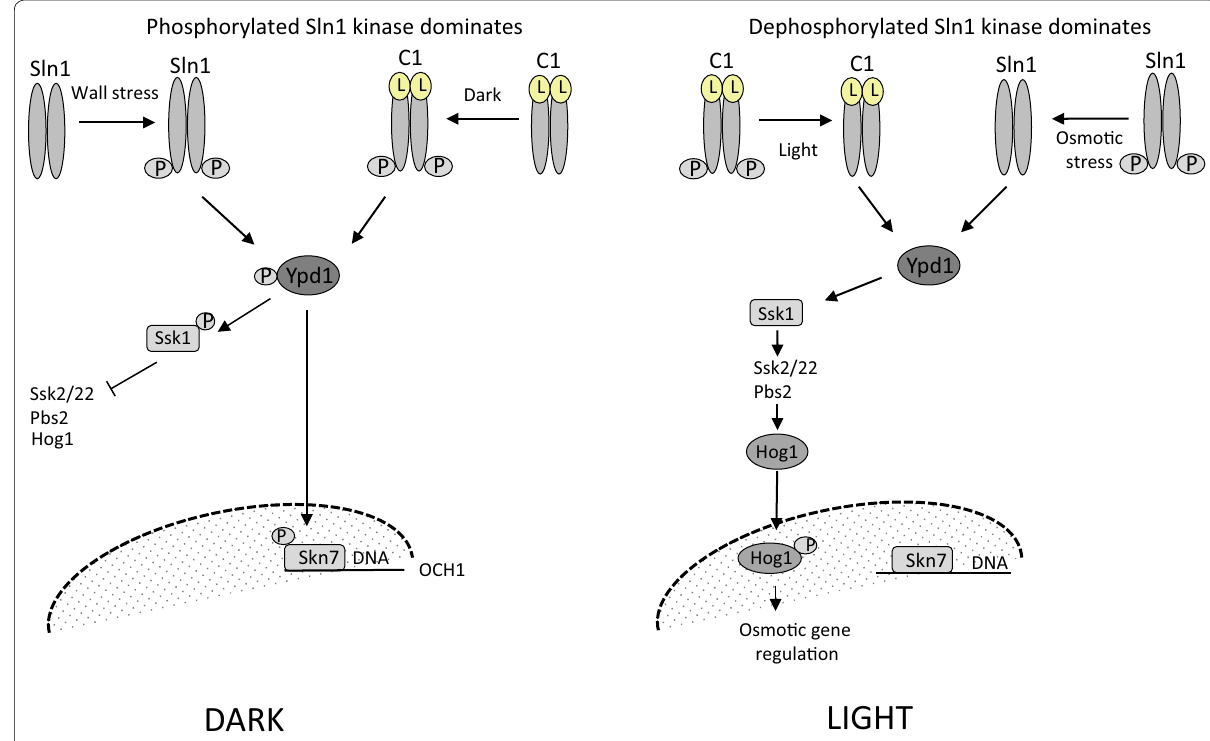
Fig. 1 Schematic drawing of the flow of phosphoryl groups through the Sln1 pathway of S. cerevisiae in the wild-type version and with a LOV- histidine kinase fusion protein replacing the Sln1 kinase. The left-hand panel shows the flow of phosphoryl groups under wall-stress conditions (maximal activity of native Sln1) and in the dark (maximal activity of the C1, fusion protein). The right-hand panel shows the absence of flow of the phosphoryl groups in the presence of osmotic stress (for the native Sln1) and upon illumination (for the C1 fusion protein). The C1 fusion protein is most active in the dark. This leads to phosphorylation of the Ssk1 and Skn7 response regulators via transfer of the phosphoryl group through the Ypd1 phospho-transfer protein. Phosphorylation of Ssk1 renders it inactive in its role in the HOG1 pathway. Phosphorylation of Skn7 leads to activa- tion of Skn7-dependent genes, such as the mannosyl-transferase, OCH1 . Osmotic stress and illumination lead to reduction in the kinase activity of Sln1 and the C1 fusion protein, respectively, and therefore accumulation of the kinase domain of Sln1 in the dephosphorylated form. This causes de-phosphorylation of the Ssk1 response regulator, which can interact with and activate Ssk2 and the Ssk22 kinases of the HOG pathway. Phospho- rylation of HOG1 leads to its translocation into nucleus and activation of the genes responsible for osmotic-stress regulation (Fassler and West